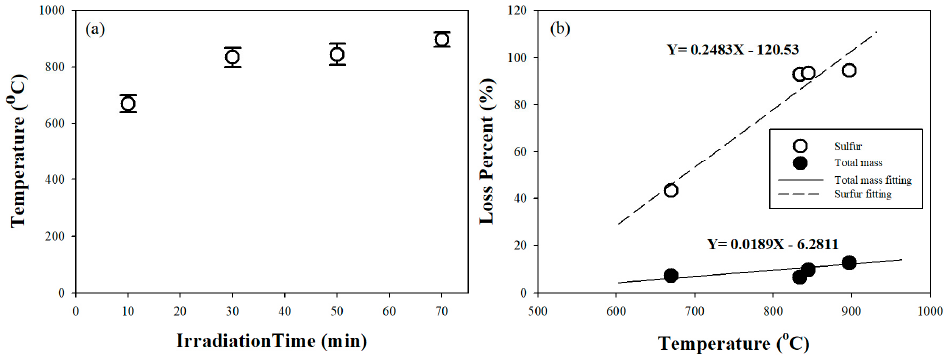
Figure 1. ( a ) Sample temperature, and ( b ) loss of the sample mass and the sulfur contents during the microwave irradiation.